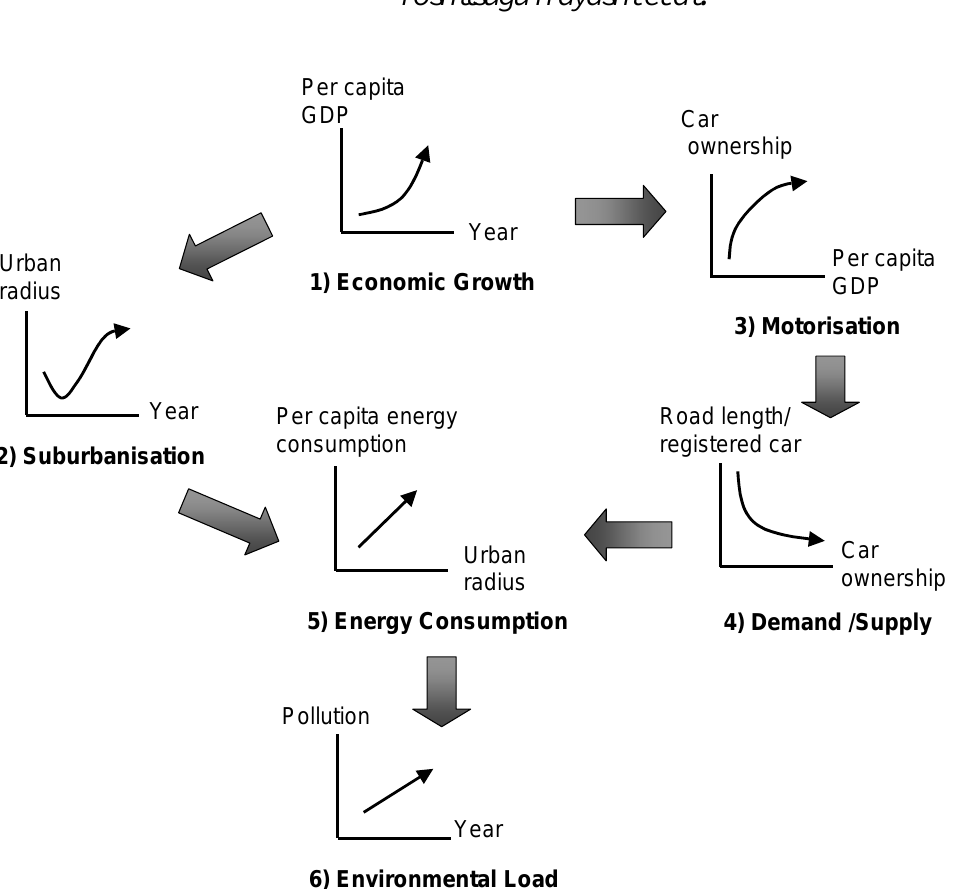
Figure 12. Quantification of causalities of deterioration in transport-related environment